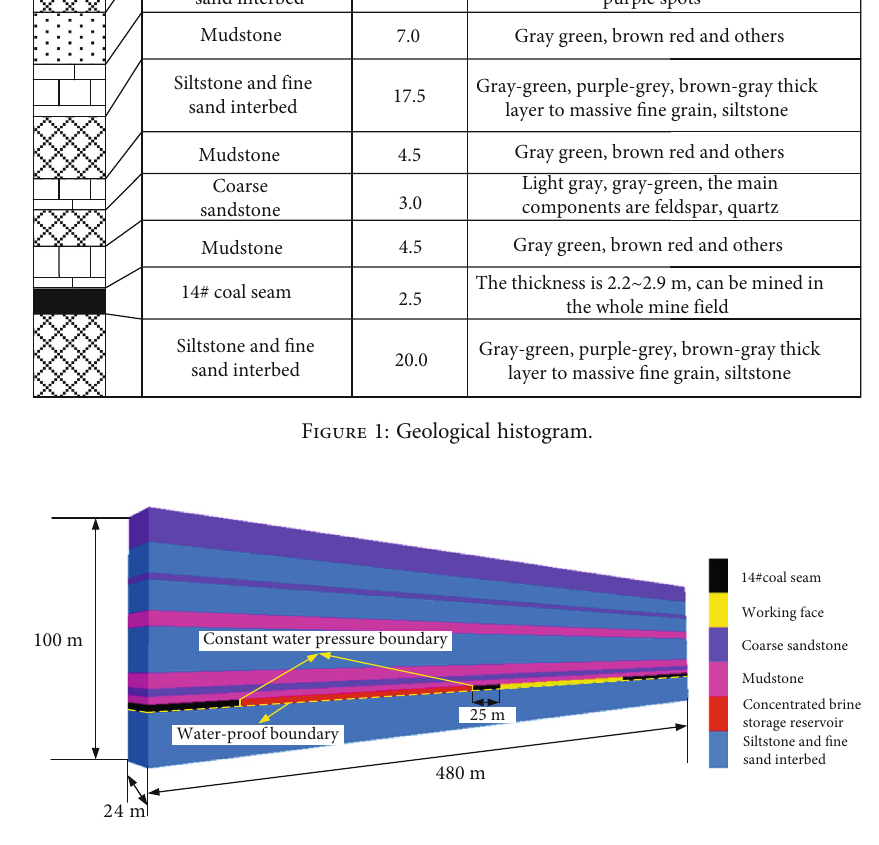
Figure 2: FLAC3D model